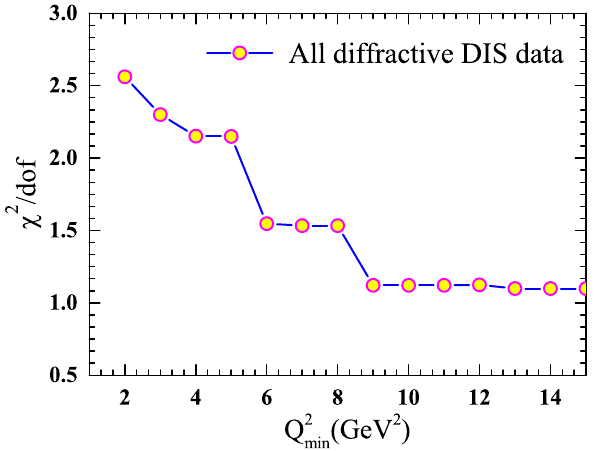
Fig. 2 Dependence of χ 2 / dof on the minimum cut value of Q 2 all data sets used in the analysis